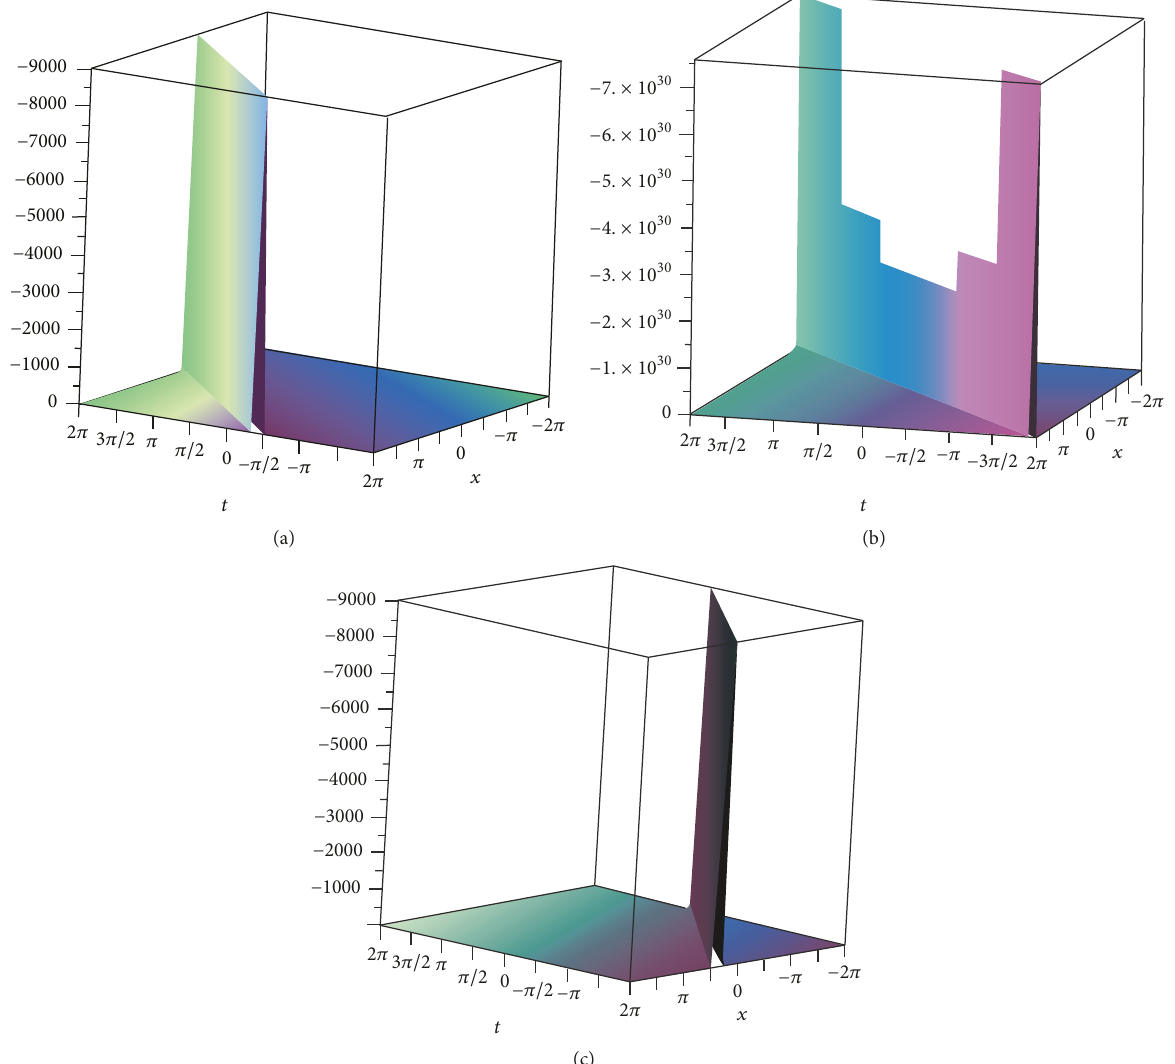
Figure 1: The solution of the Vakhnenko-Parkes equation corresponding to 𝑊 𝑟 (𝑧) , (a) 𝑧 0 = 5 , (b) 𝑧 0 = 0 , and (c) 𝑧 0 = −5